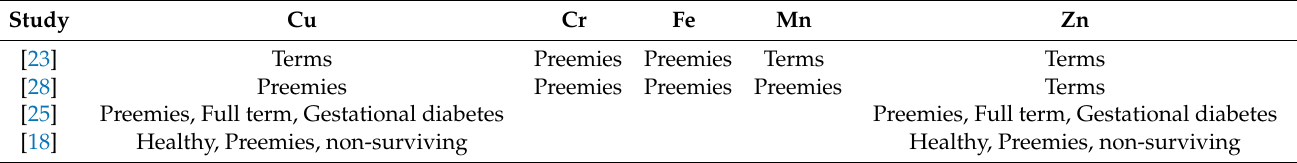
Table 2. Specification of subjects.